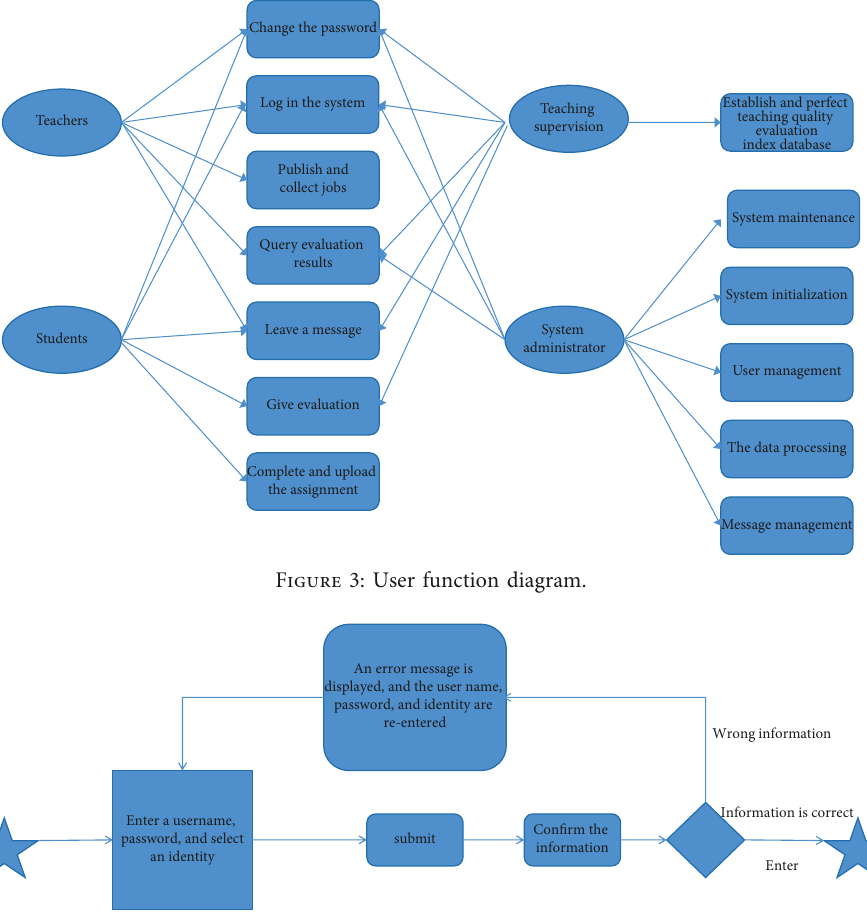
Figure 4: User login system activity